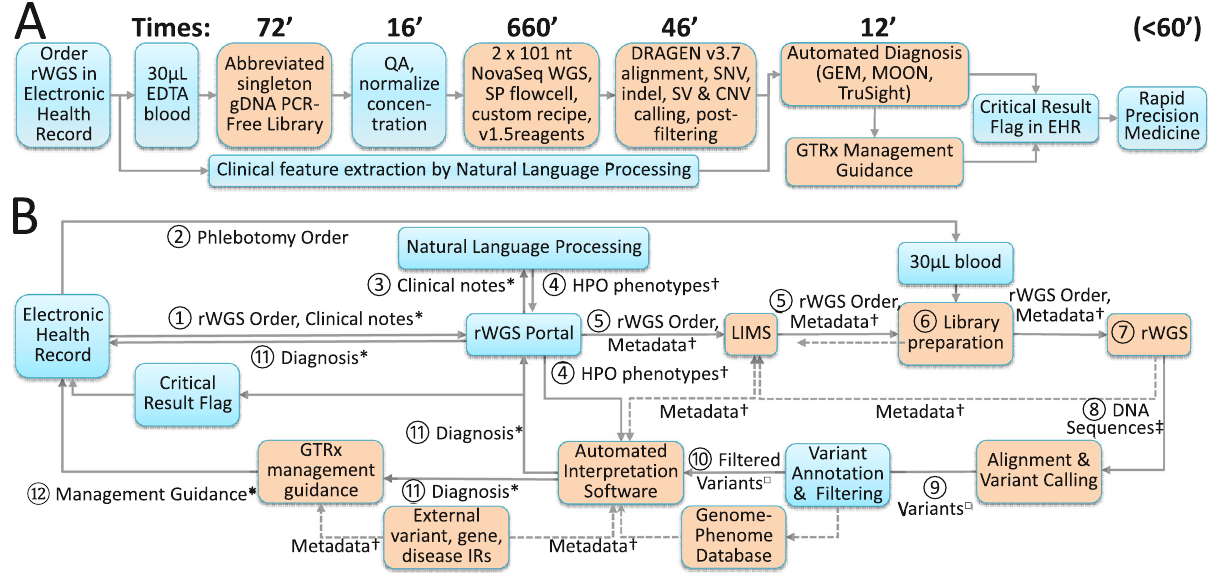
Fig. 1 Flow diagrams of the technological components of a 13.5-hour system for automated diagnosis and virtual acute management guidance of genetic diseases by rWGS. Innovations described herein are indicated by orange boxes. A The order and duration of laboratory steps and technologies. EHR Electronic Health Record, EDTA EthyleneDiamineTetraAcetic acid, gDNA genomic DeoxyriboNucleic Acid, PCR Polymerase Chain Reaction, QA Quality Assurance, nt Nucleotide, SNV Single Nucleotide Variant, indel insertion-deletion nucleotide variant, SV Structural Variant, CNV Copy Number Variant, GTRx Genome-to-Treatment. B Diagram of the information fl ow from order placement in the EHR to return of diagnostic results together with speci fi c management guidance for that genetic disease. rWGS Portal: Custom software system for rWGS ordering, accessioning, chain-of-custody, and return of results (v.3.2). LIMS Custom laboratory information management system for rWGS, short tandem repeat pro fi ling, con fi rmatory testing (Sanger sequencing and Multiplex Ligation-dependent Probe Ampli fi cation), and inventory management (L7 informatics). IR Information resource, *: HL7/FHIR or Continuity of Care Documents, † : JSON. ‡ : bcl, □ : SV and CNV detection (Witty.Er), de fi nes true positive matches more conservatively than in clinical diagnostic practice 35 .